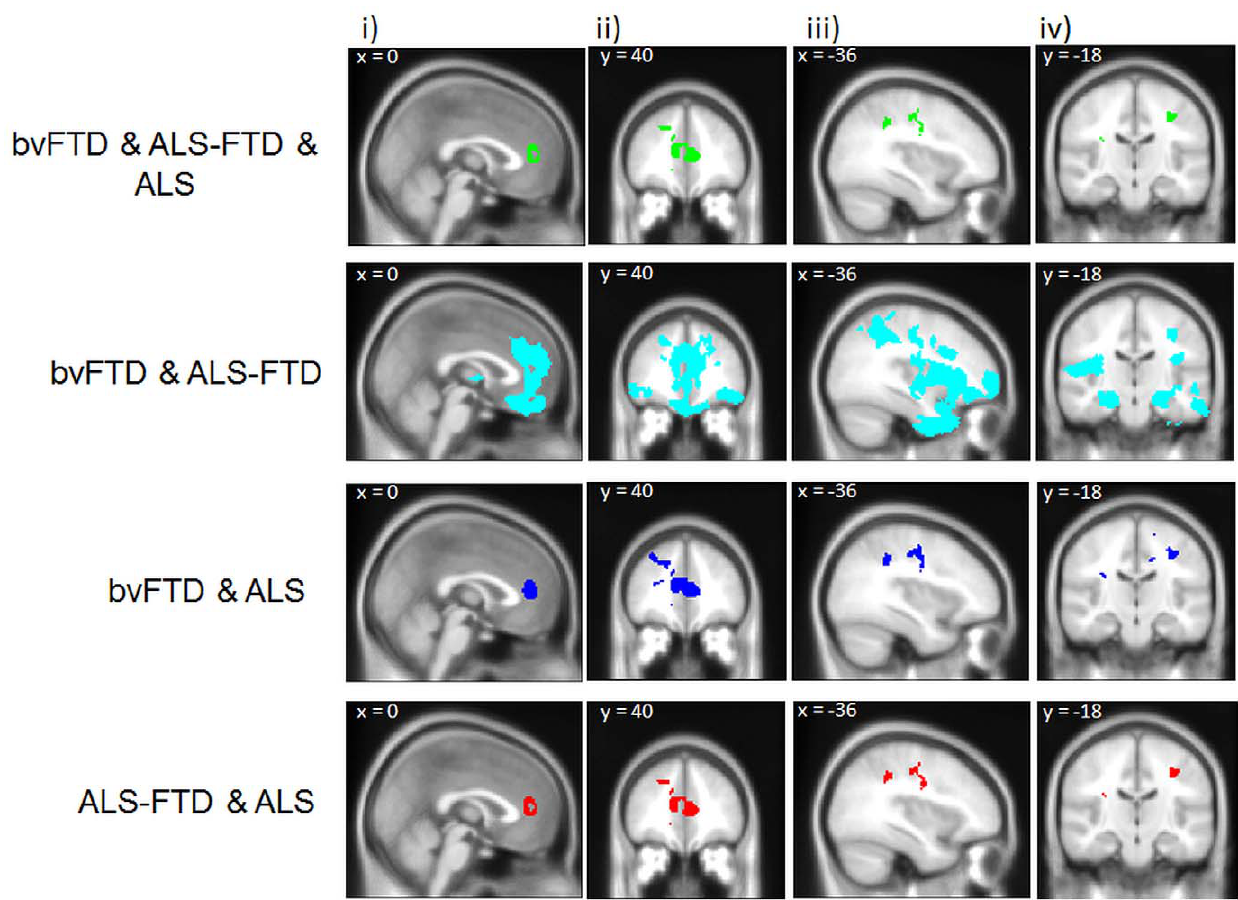
Figure 2. Overlap grey matter atrophy across patient groups. Voxel-based morphometry analysis showing region of brain atrophy overlap; i) and ii) show sagittal and coronal views of the anterior cingulate atrophy cluster; iii) and iv) show sagittal and coronal views of the motor cortex atrophy cluster. Clusters are overlaid on the MNI standard brain (t=2.41).